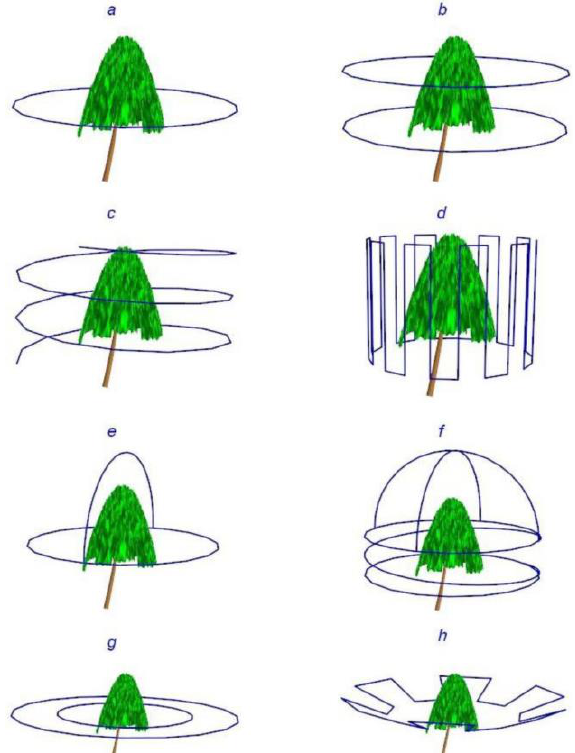
Figure 3 . UAV trajectories for image acquisition (Gatziolis et al., 2015)